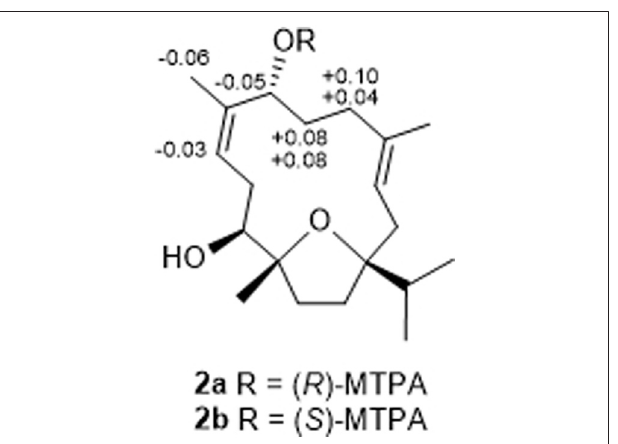
FIGURE 5 | Results of compound 2 with the modi fi ed mosher ’ s method ( Δ δ H (cid:2) δ S − δ R